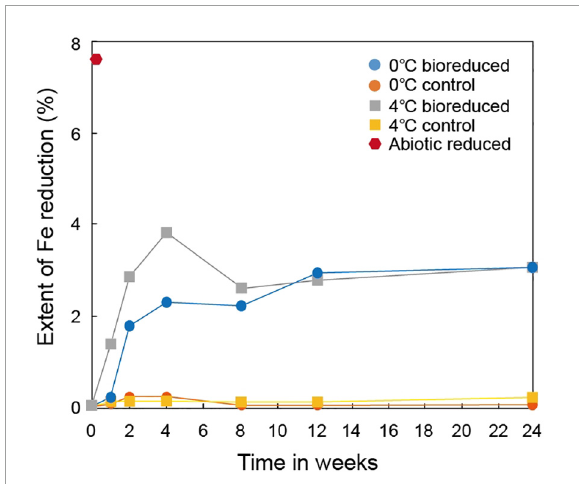
FIGURE1 Extent of biotic and abiotic Fe reduction in IMt-1 during batch experiment at various temperatures (0 and 4 ◦ C) and incubation